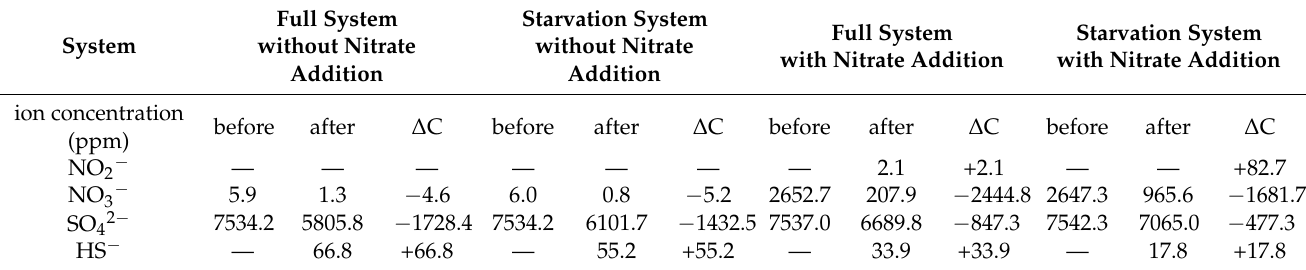
Table 1. Concentrations of HS − , SO 42 − , NO 3 − , and NO 2 − before and after 14 days of incubation in different systems.